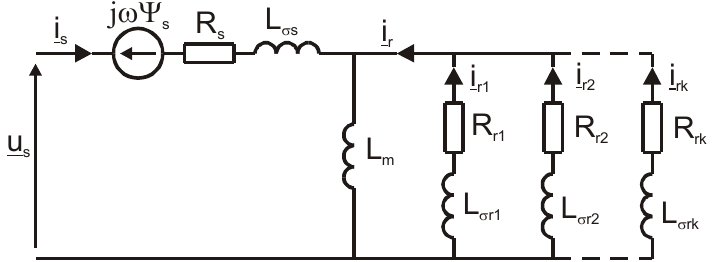
Figure 1. Multiloop equivalent circuit of an induction machine.